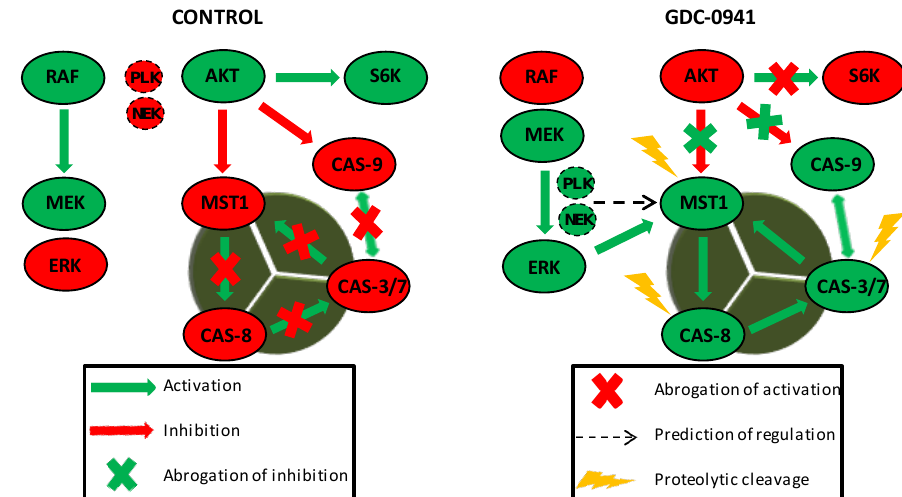
Figure 6. MST1 acts as a regulator of the extrinsic apoptotic pathway in Jurkat T cells. PI3K signaling blockade by GDC-0941 resulted in the abrogation of AKT kinase phosphorylation at S473 and significantly attenuated the phosphorylation of P70S6K and c-RAF kinase. This led to a paradoxical increase in the phosphorylation of MEK1/2 at S217/S221 and ERK1/2 at T202/Y204 followed by the activation of MEK-ERK signaling. Active ERK1/2 signaling stimulated the proteolytic activation of MST1 which was insensitive to the experimentally determined concentration of the Z-DEVD-FMK inhibitor. At selected concentrations, Z-DEVD-FMK effectively blocked the activity of caspase-3, -7 and -9 but was insufficient to block the proteolytic activation of caspase-8, suggesting the potential activation of MST1 by caspase-8. On the other hand, the inhibition of MST1 levels by siRNA significantly reduced the proteolytic activation of caspase-3, -7 and -8, rendering MST1 a potential regulator of caspase-8 activity in Jurkat T cells. Moreover, activity of caspase-3/-7 potentiates the proteolytic activation of MST1, hence we presume the existence of a positive feed-back loop orchestrated by MST1 to amplify the apoptotic signal in Jurkat T cells. PLK1 and NEK2 were predicted as potential regulators of MST1 activity during PI3K signaling blockade. Cleavage of caspase-9 was not determined in this